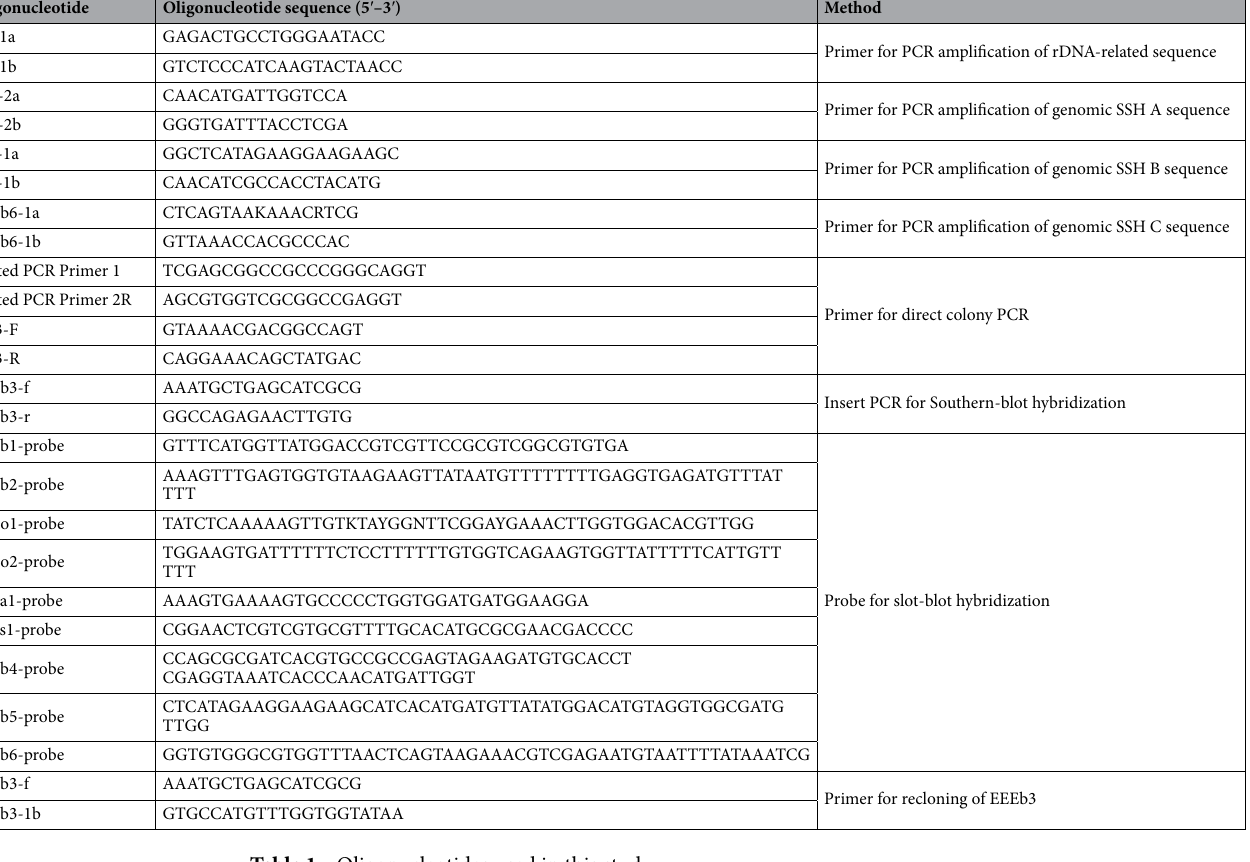
Table 1. Oligonucleotides used in this